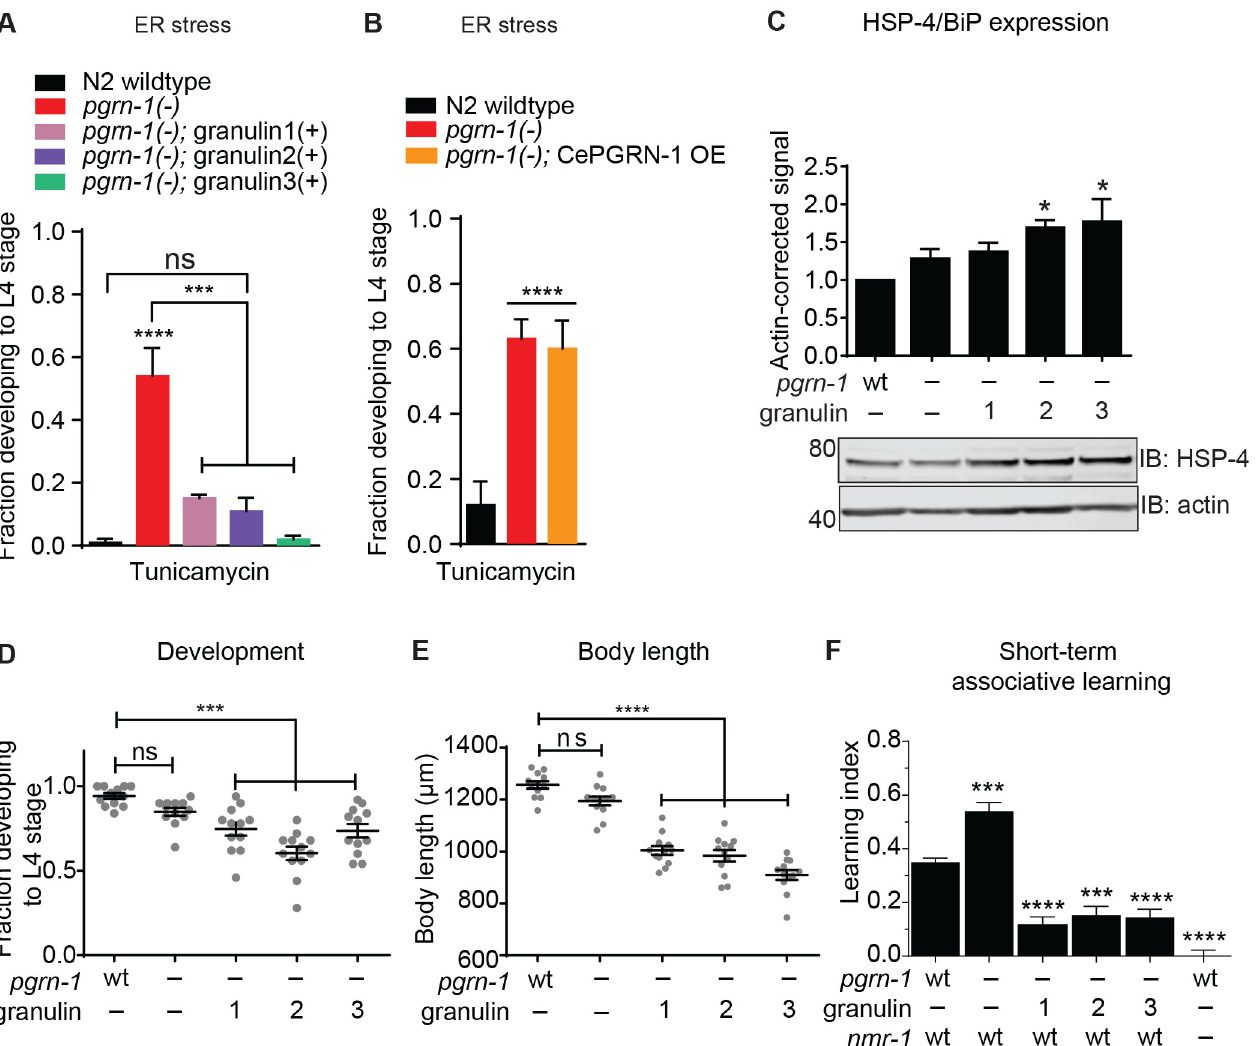
Fig 1. C . elegans granulins impair organismal fitness and resistance to ER stress. ( A ) Wild-type (N2) and pgrn-1(-) animals with and without granulin expression were subjected to ER stress with tunicamycin (5 μ g / ml). The fraction developing to L4 stage was quantified (n = 50, 3 biological replicates). ( B ) Wild-type (N2) and pgrn-1(-) animals with and without C . elegans progranulin over-expression (OE) were subjected to ER stress with tunicamycin (5 μ g / ml). The fraction developing to L4 stage was quantified (n = 50, 3 biological replicates). ( C ) Total worm lysates from synchronized day 1 adult granulin-expressing animals were immunoblotted with an anti-HSP-4/BiP antibody (3 biological replicates). Anti-actin was used as a loading control. ( D ) Wild-type and pgrn-1(-) animals with and without granulin expression were staged as embryos. Animals were scored for development to L4 stage (n = 50, 12 biological replicates). ( E ) Measurement of body length at day 1 adulthood (n = 12). ( F ) Measurement of short-term associative learning (three biological replicates). The glutamate receptor mutant nmr-1(ak4) was used as a positive control. Throughout, error bars show mean ± SEM, one or two-way ANOVA with post-hoc Tukey multiple comparisons test. Comparisons are to wild-type unless otherwise indicated ( � P < 0.05, ��� P < 0.001, ���� P < 0.0001, ns = not significant, wt = wild-type).